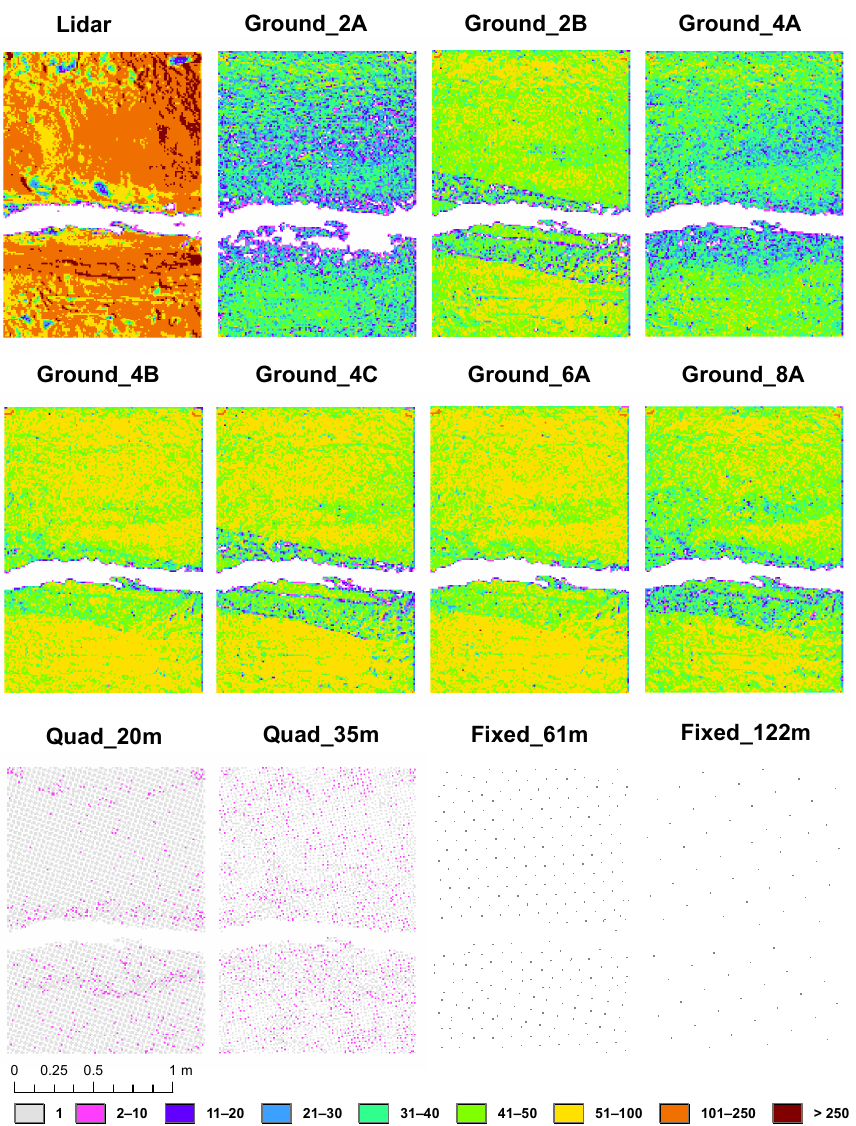
Figure 6. Sampling intensity using the quadrat method for each dataset considered. The individual colors represent point sampling count intervals within a 1 × 1cm virtual grid. Points located in the channel were removed to match the area covered by the lidar dataset (herein considered as a